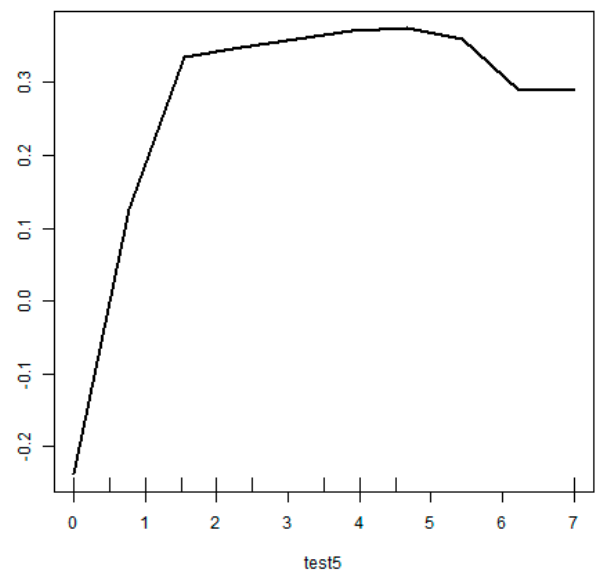
Figure 4. Partial dependence plot (CDR sum of boxes).